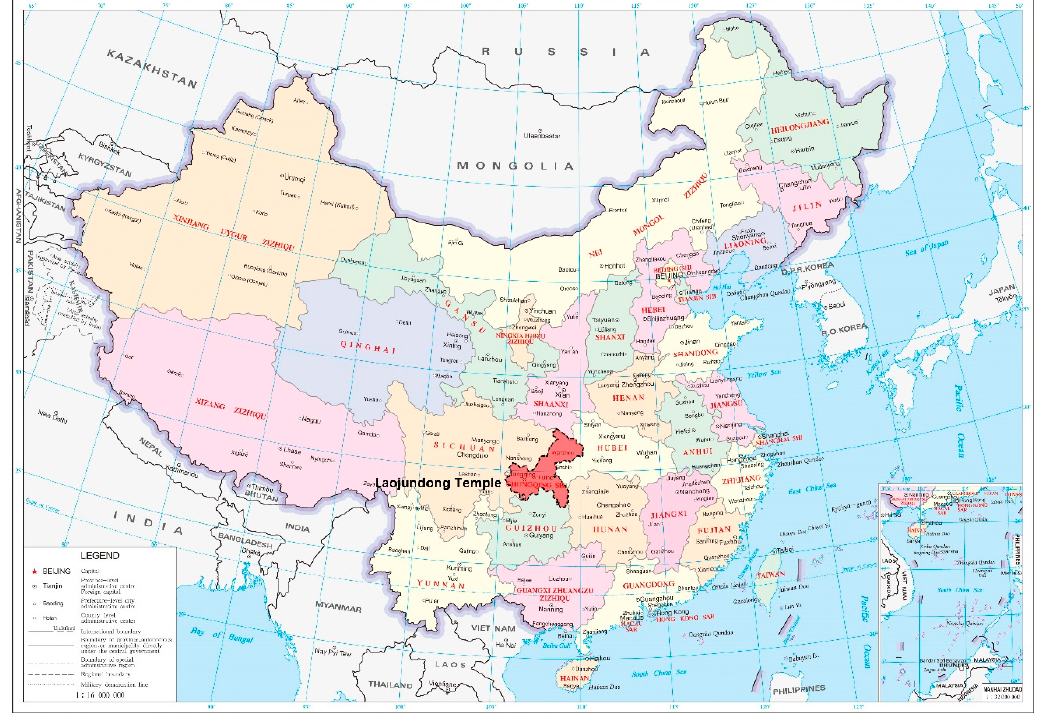
Figure 1. The location of the Laojundong Temple in Chongqing, China.